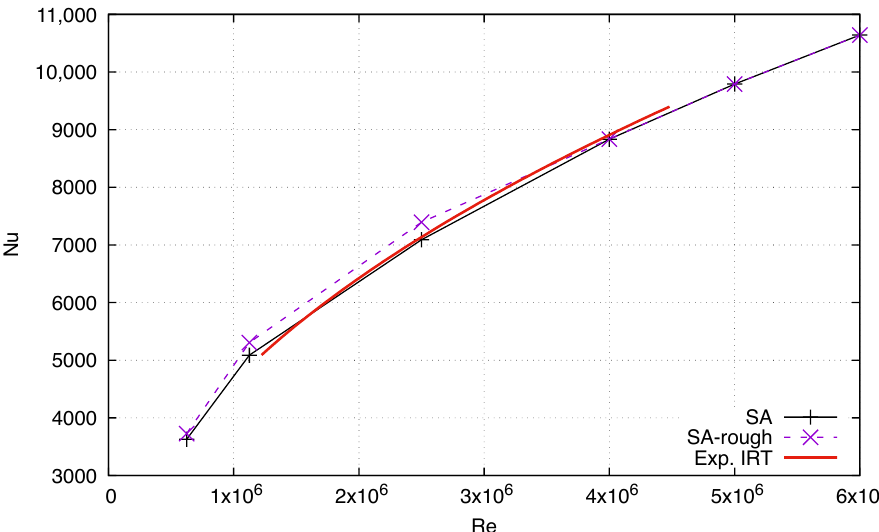
Figure 7. Nu at the leading edge: comparison between CFD results and experimental correlation Nu = 6.818 Re 0.472 for the NACA 0012 at α =